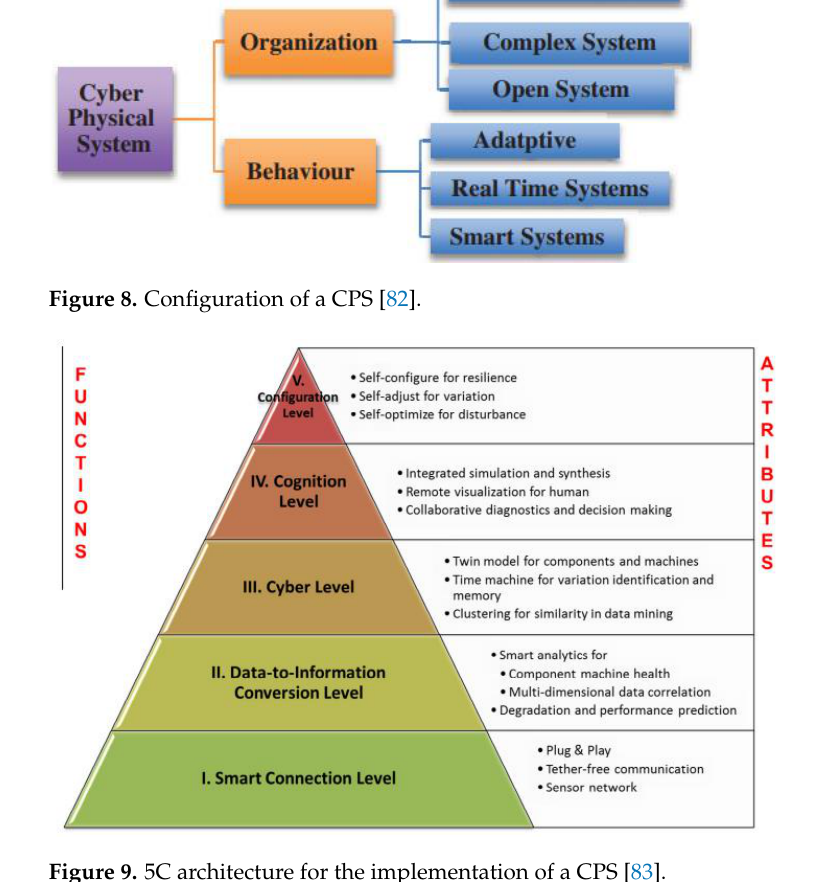
Figure 9. 5C architecture for the implementation of a CPS [83].